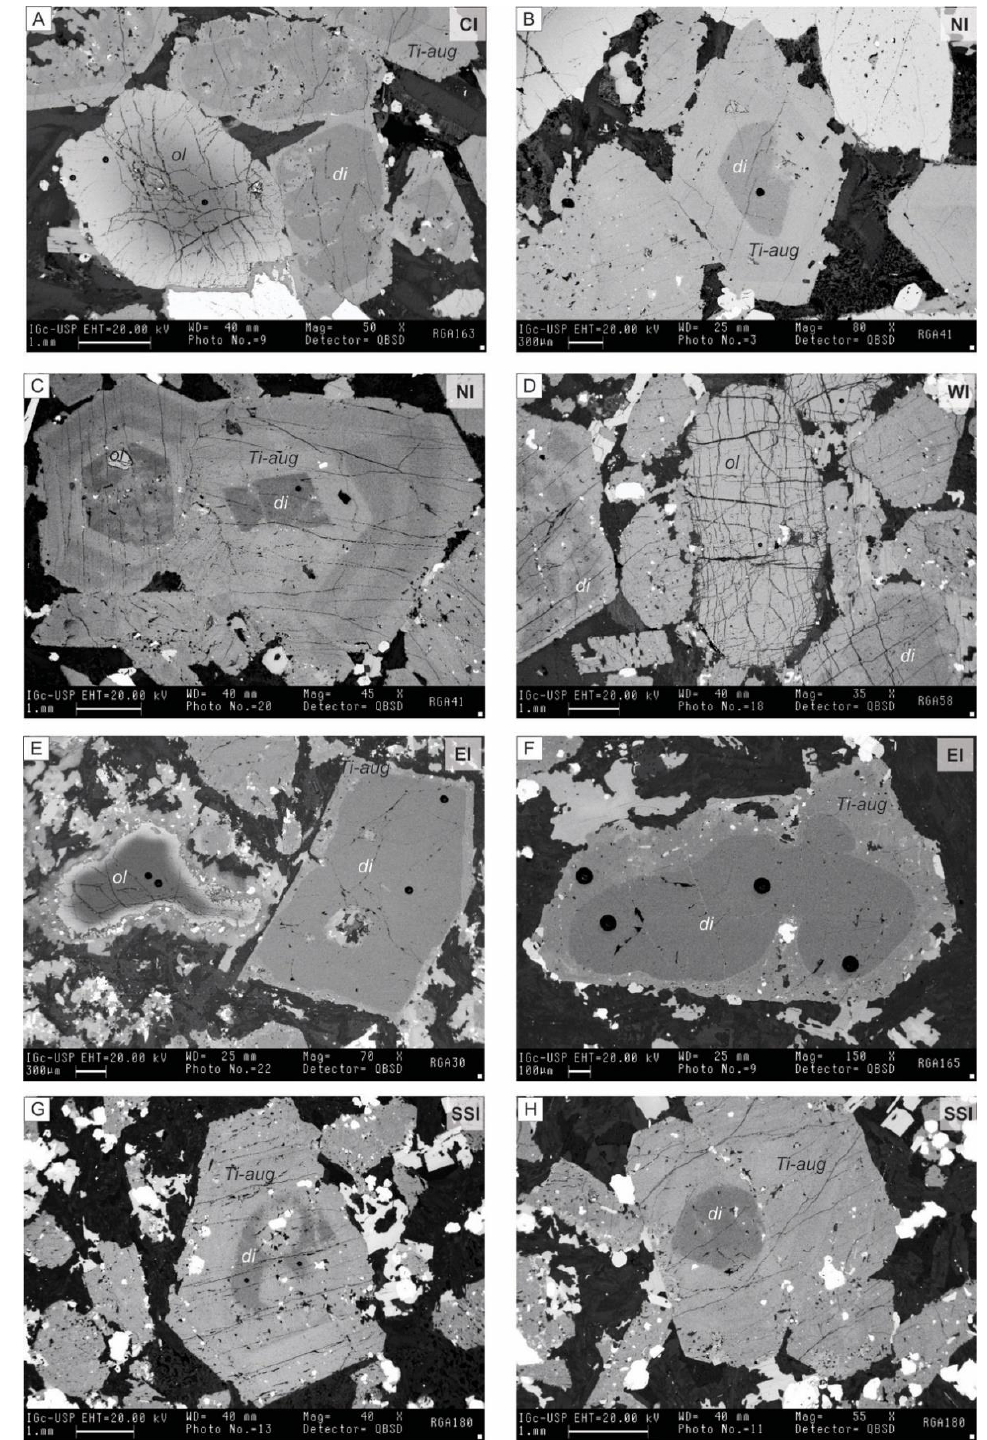
Figure 3. Backscattered electron images of clinopyroxene and olivine primocrysts of the Ponte Nova mafic – ultramafic alkaline massif. Relict cores of high-Mg diopside compositions are found in complex-zoned crystals of all intrusions ( A – H ). Mantling and rims of clinopyroxene crystals are mainly formed by Ti-augite ( A – H ). Mostly, the relic cores of diopside are partially corroded, presenting more rounded forms, typical of antecrysts. Zoned olivines with high-Mg cores are found mostly in CI ( A ) and EI ( E ), whereas typical cumulatic olivines, as in WI ( C ) are almost unzoned. Utilized mineral abbreviations: di, diopside, ol, olivine; Ti-aug, titanaugite.